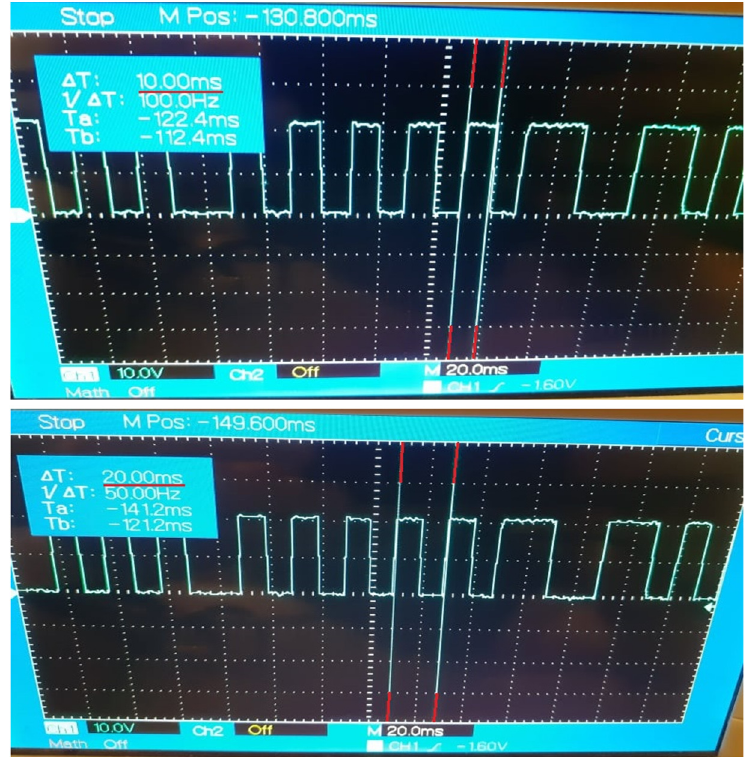
Figure 6. Generated Digital Signal based on payload delivered by the Gateway Application at 10 ms recurrence.